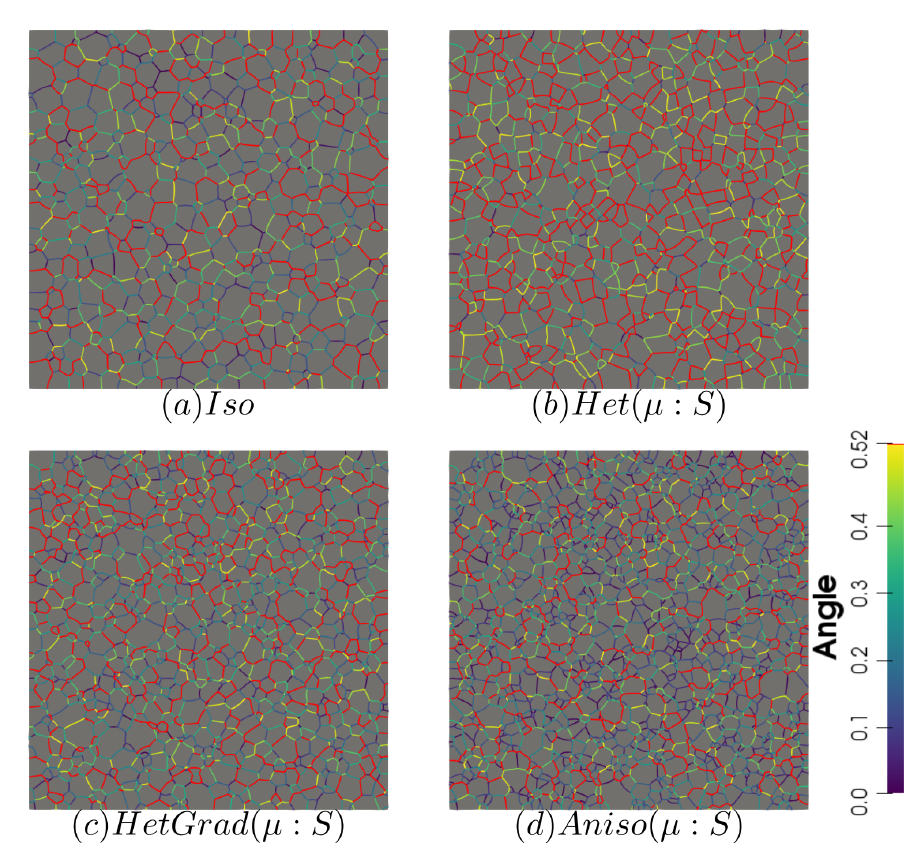
Figure A14. Disorientation of the boundaries using the four formulations with heterogeneous grain boundary mobility at t = 1 h. Boundaries with a disorientation higher than 30 ◦ are colored in red.